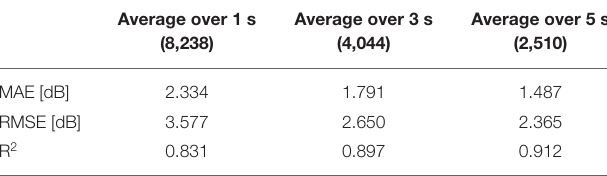
TABLE 5 | Performance comparison between different averaging